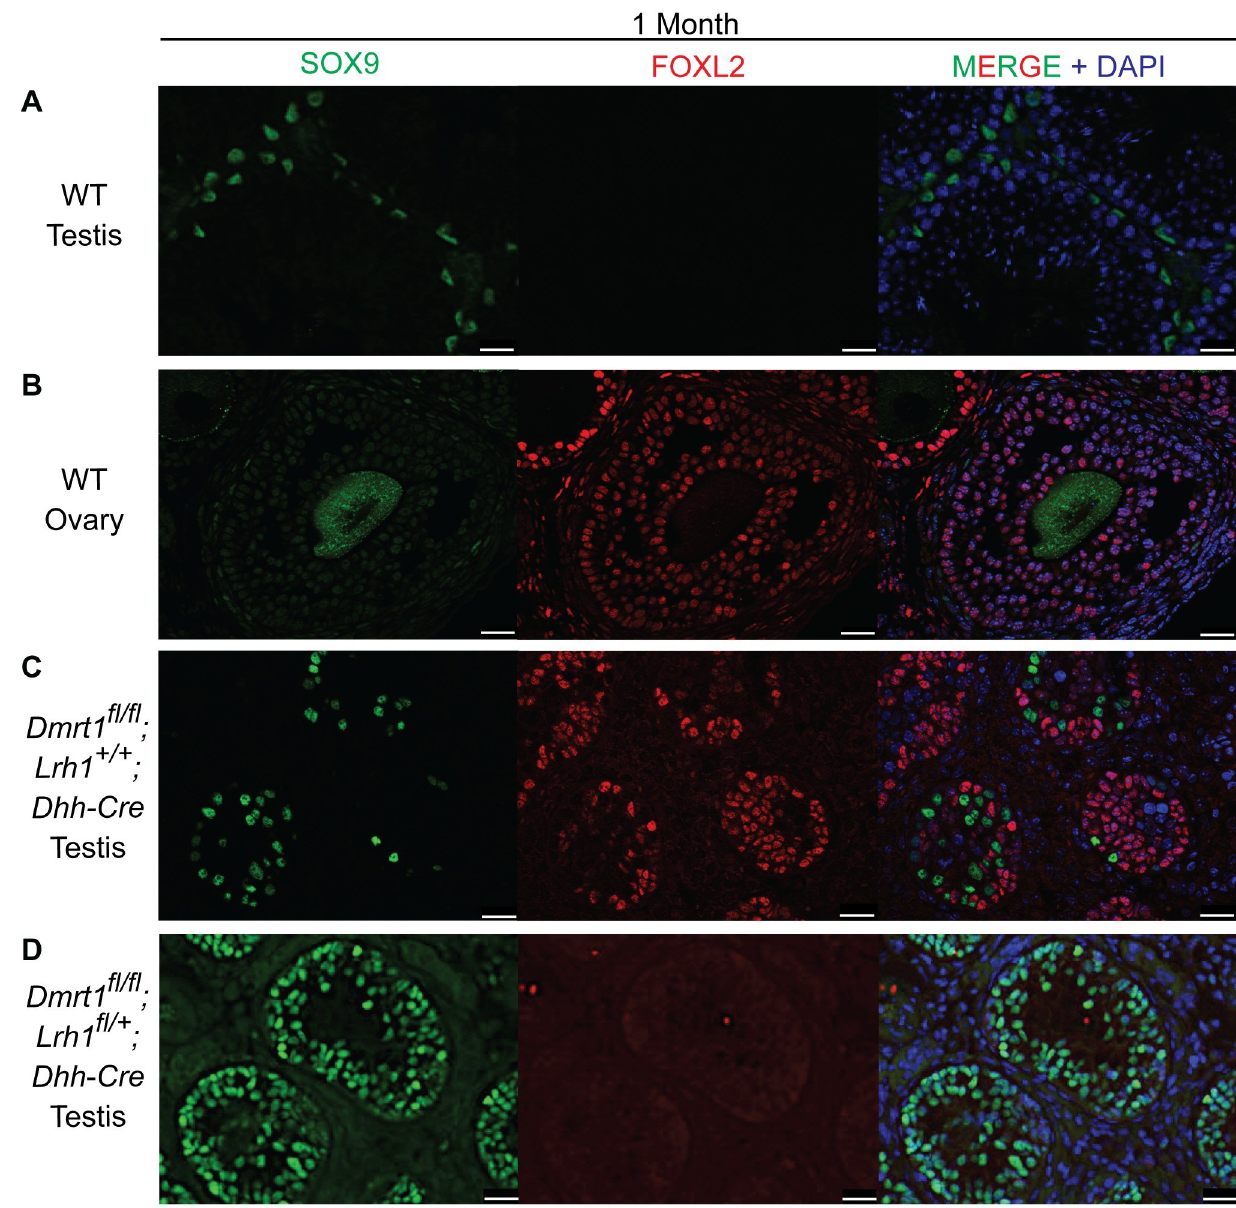
Fig 2. Lrh1 is required for sexual cell fate transdifferentiation of Dmrt1 mutant XY gonads. Immunofluorescence of gonads from one month old mice stained for the Sertoli cell marker SOX9 (green), the granulosa cell marker FOXL2 (red) and the DNA stain DAPI (blue). Genotypes shown are: (A) Wild type XY testis; (B) Wild type XX ovary; (C) XY gonad conditionally homozygous in Sertoli cells for Dmrt1 deletion; (D) XY gonad conditionally homozygous in Sertoli cells for Dmrt1 deletion and heterozygous for Lrh1 deletion. Scale bars: 20 um. normal numbers in conditionally targeted gonads relative to floxed controls lacking the Cyp17iCre transgene. Reproductive function also was normal in Leydig cell conditional mutants: testis size was unaffected at one year (Fig 5A); adult epididymi were filled with sper- matozoa (Fig 5B and 5C); and conditionally-mutant males sired normal-sized litters. Condi- tionally-targeted Leydig cells also had normal expression of the key steroidogenic enzyme SCC (CYP11A1) (Fig 5D and 5E). Together with the lack of detectable Lrh1 expression in Leydig